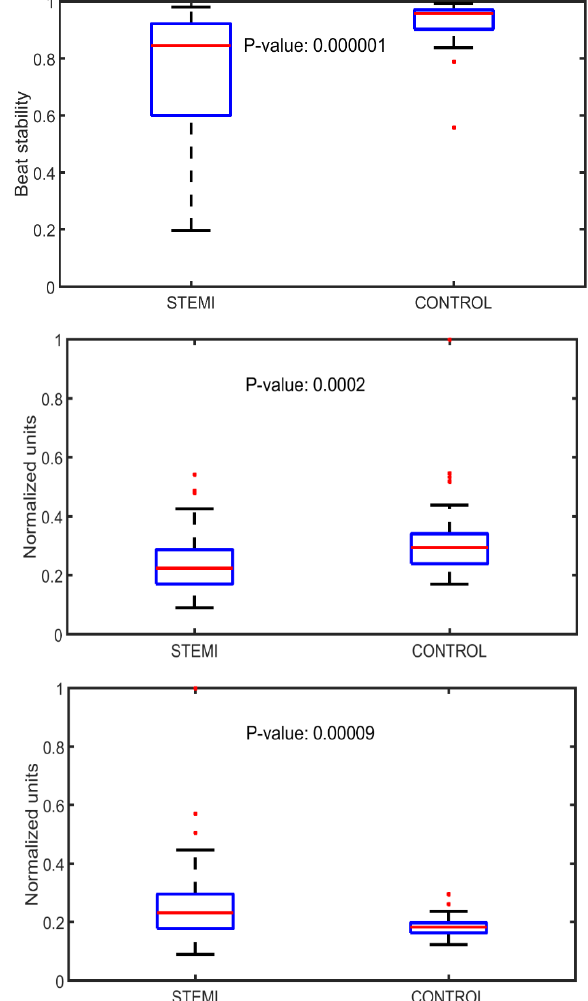
Figure 5. Plots representing median of beat stability (band-pass filter 20–90 Hz) in AccX axis in a window around second heart sound ( Upper panel), systole/diastole ratio in signal strength in GyroX axis ( Middle panel), and median value of signal amplitude (band-pass filter 10–80 Hz) around third heart sound in AccZ axis ( Lower panel) in STEMI and control